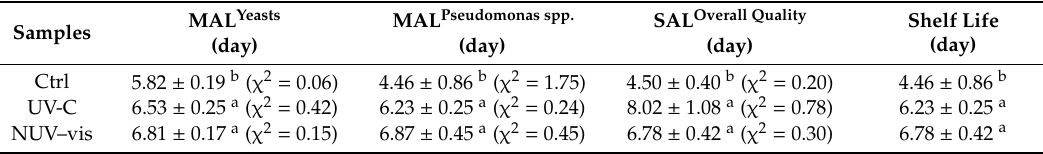
Table 1. Microbiological acceptability limit (MAL) and sensory acceptability limit (SAL) measured on a day as fitting parameters of Equations (1) and (2) to microbiological and sensory experimental data, respectively. The goodness of fitting was evaluated by the χ 2 value. The values of shelf life are the lowest value among the two MAL and the SAL for each sample. Ultraviolet light-treated cheese = UV-C; Near-UV-visible light-treated cheese = NUV–vis; Control sample (inoculated and not treated) = Ctrl. MAL Yeasts MAL Pseudomonas spp. SAL Overall Samples (day) (day)